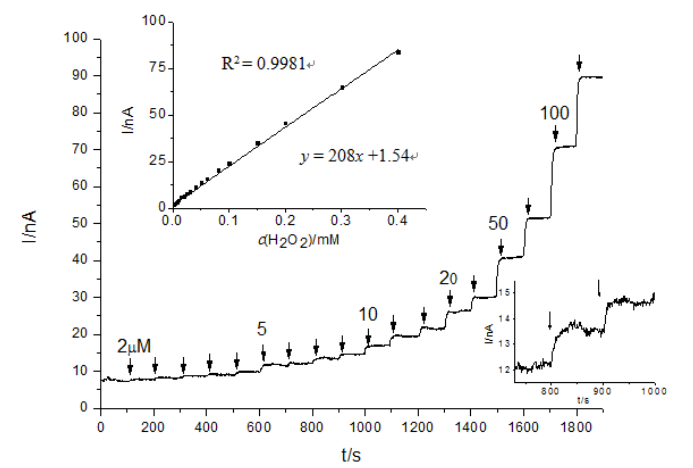
Figure 3. Amperometric performance of CSPEs for detection of H 0.1 M phosphate buffer solution, pH 7.5. The upper left inset shows the calibration curve of O concentration; the lower right inset zooms in the part of the amperometric CSPEs for H 2 2 response of 5 μ M H O injected. 2 2